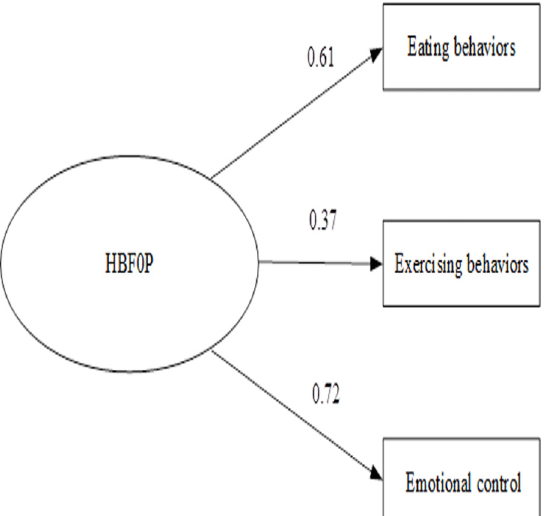
Figure 3. Confirmatory factor analysis of health behavior for obesity prevention among primary school students in Bangkok, Thailand. Chi-square = 0.00, df = 1, p-value = 0.977, RMSEA = 0.00.